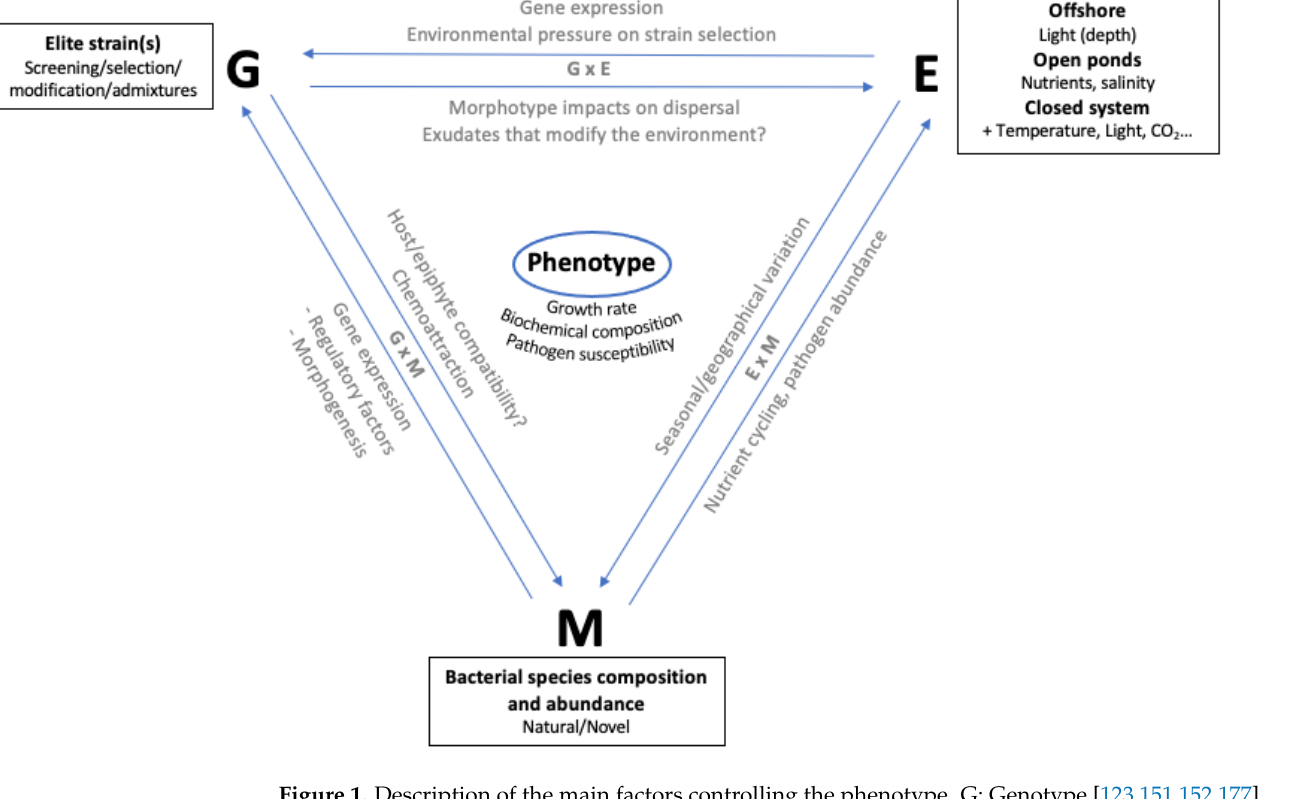
Figure 1. Description of the main factors controlling the phenotype. G: Genotype [123,151,152,177]. Elite or strains of interest can be selected by screening wild type strains and/or the creation of artificial populations. E: Environment [103,125,159,161]. M: Microbiome [155,156,169]. Variations in the impact of the microbiome on Ulva phenotype are expected via qualitative and qualitative changes in bacterial composition. Importantly, the interactions between those three factors are also expected to influence Ulva phenotype.